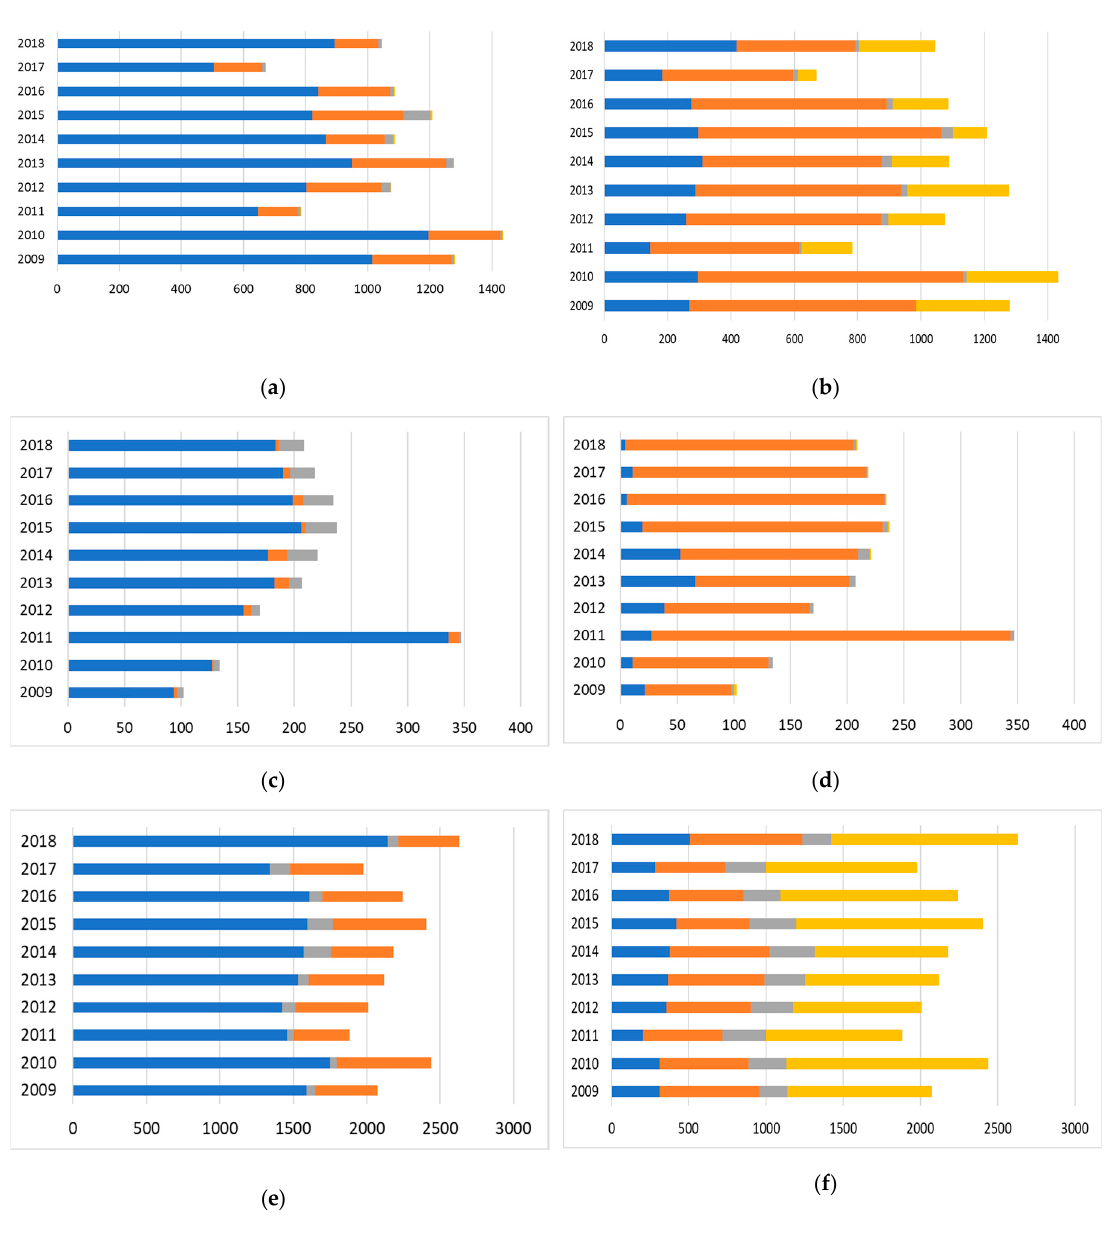
Figure 6. Summary of water trade activity by sector in California, Texas, and Western US (2009–2018). ( a ) Volume sold by sector (1000 AF) in California; ( b ) volume purchased by sector (1000 AF) in California; ( c ) volume sold by sector (1000 AF) in Texas; ( d ) volume purchased by sector (1000 AF) in Texas; ( e ) Volume sold by sector (1000 AF) in the Western US; ( f ) volume purchased by sector (1000 AF) in the Western US. Source: Authors’ calculations and WestWater Research. Note: The western states include Arizona, California, Colorado, Idaho, Montana, Nevada, New Mexico, Oregon, Texas, Utah, Washington, and Wyoming. Note that we did not have state-level data on Arizona.